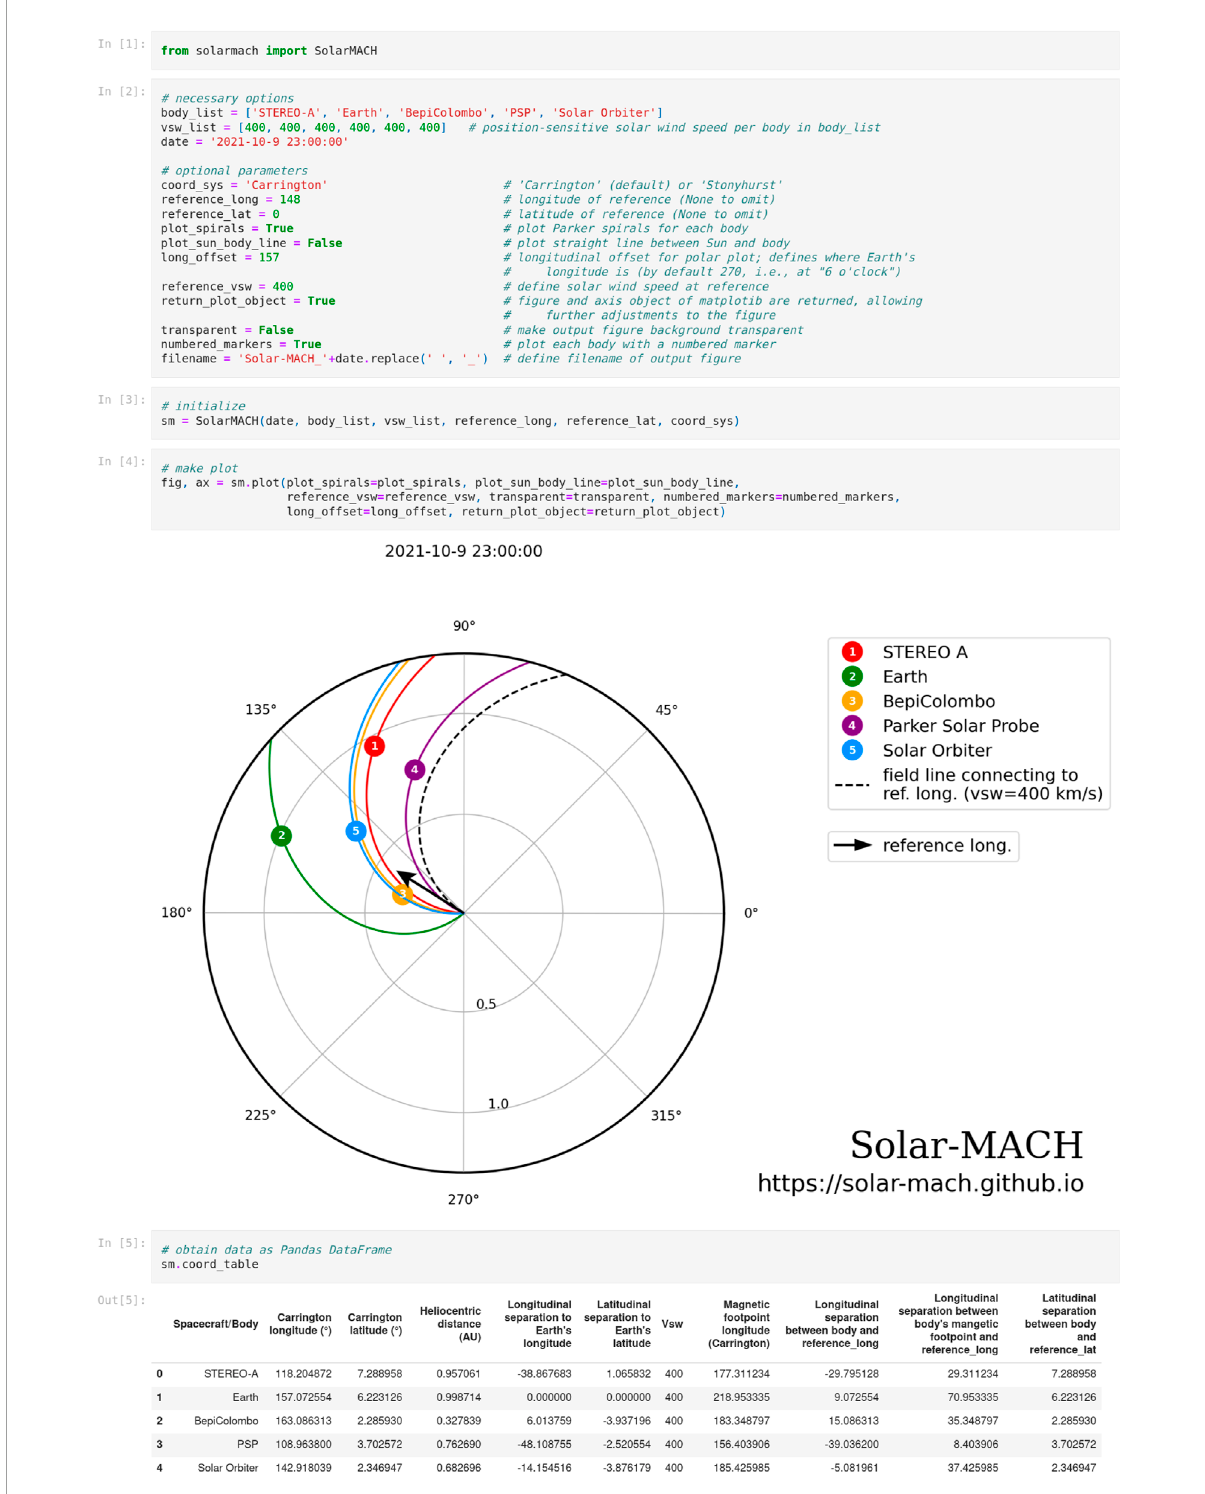
FIGURE 2 Example of using the Python package solarmach in a Jupyter Notebook for the SEP event on 9 October 2021.